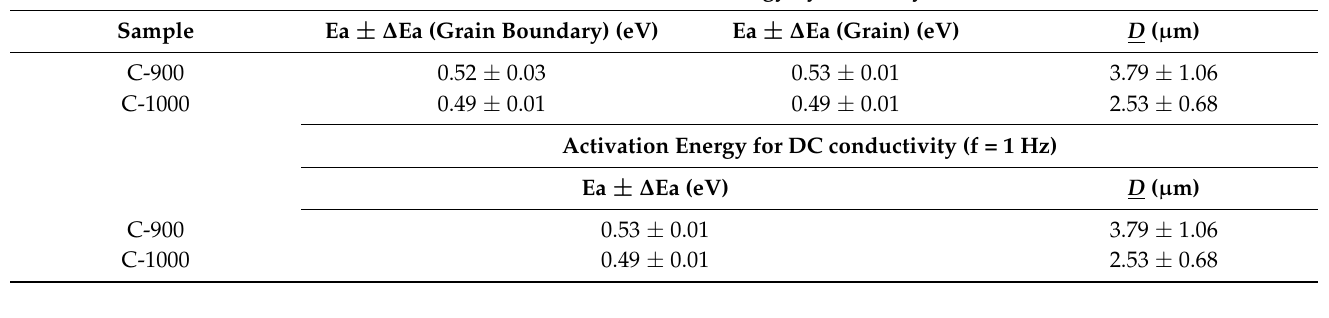
Table 3. Grain and grain boundary activation energy obtained by BLM and DC conductivity for C-900 and C-1000 ceramics.